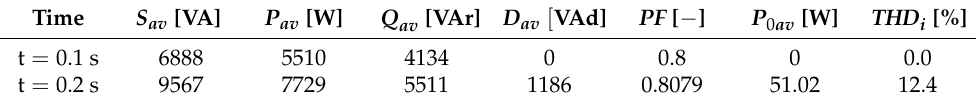
Table 42. Simulation results before and after the change (at steady states). Power component average values, computed in Matlab/Simulink are given in Table 42. Time